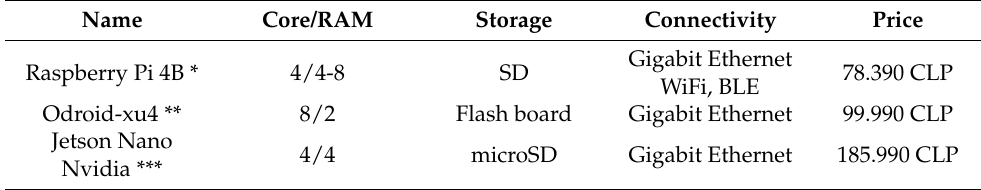
Table A5. Characteristics of computing devices.